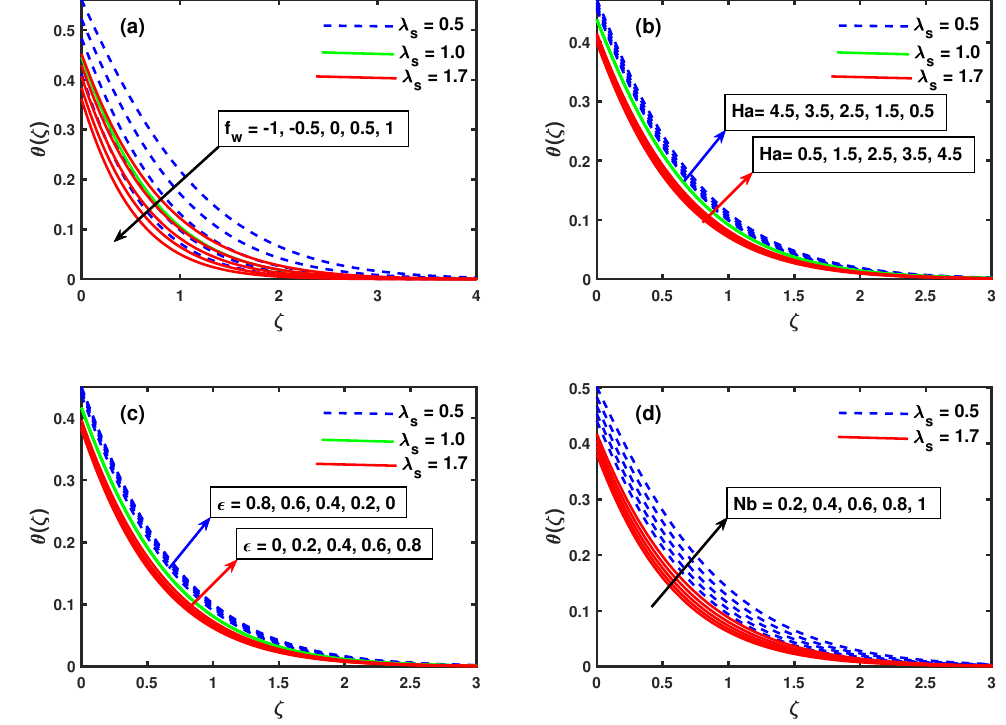
Figure 3. Fluctuation of temperature profile ( θ ( ζ ) ) along with f w (suction/injection) ( a ), Hartmann number ( Ha ) ( b ), material power law index ( (cid:101) ) ( c ), and Brownian motion ( Nb ) ( d ). A description for altering behavior of non-dimensional temperature θ ( ζ ) is provided for λ s < 1 (slow stretching) and λ s > 1 (fast stretching). It observed that the temperature function for ( λ s < 1 ) is larger than the case of ( λ s > 1 ) , as drawn in the following plots in Figure 3a–d to visualize respectively, the impacts of f w , Ha , (cid:101) , and Brownian motion parameter Nb . A first sight reveals that larger injection( f w < 0) raises the curve of θ ( ζ ) but higher suction ( f w > 0 ) declines θ ( ζ ) . The magnetic field’s intensified strength to yield greater value for Ha has enlarged θ ( ζ ) , and the thermal boundary layer loses its thickness (see Figure 3b). The physical reason for this outcome is associated with the enhanced resistance to the flow of fluid. Figure 3c,d respectively exhibit the effect of incremented values of (cid:101) and Nb resulted in higher temperature distribution because of the increasing (cid:101) , the shear thickening of fluid is enhanced to capture more heat, and the high value of Nb associated with the intensified random motion of the nanoparticles can efficiently diffuse heat in the fluid. Nt measures thermophoresis, and it stands for transportation of nanoparticles from hot to cold